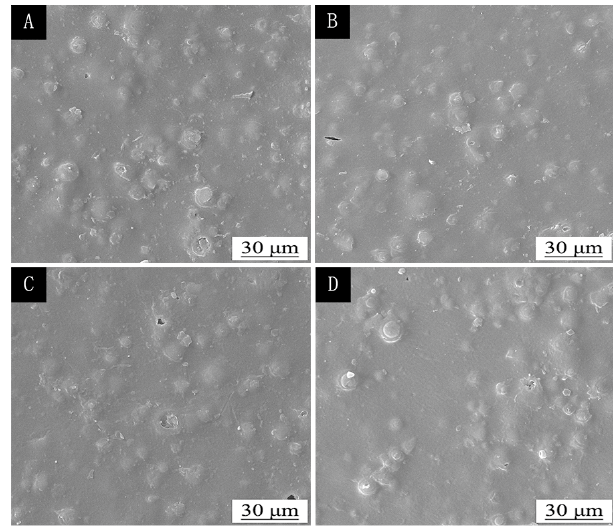
Figure 9. SEM images of reversible color-changing coating with the color-changing microcapsules added in the topcoat in the different coating technologies: ( A ) #5; ( B ) #6; ( C ) #7; ( D ) #10.